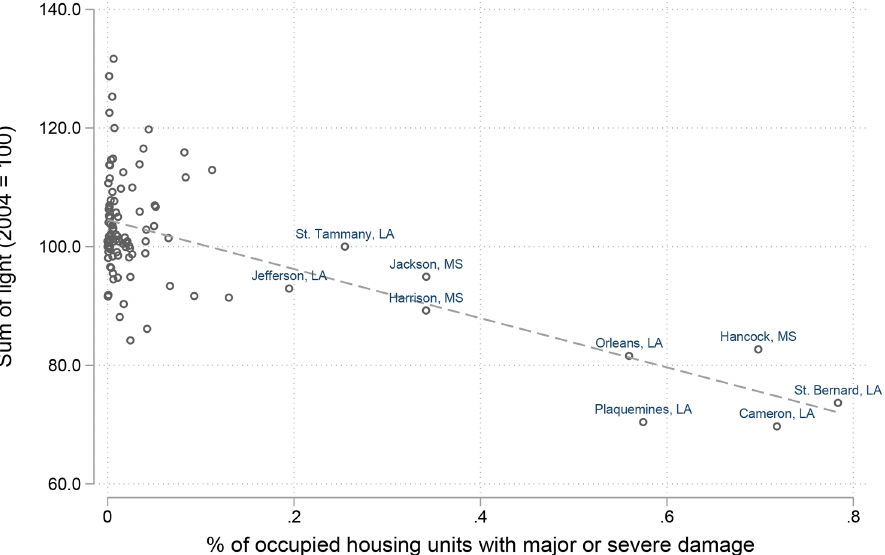
Figure 3. Correlation plot of housing damage and night light reduction in 2005. Data on housing damage in 2005 for Louisiana and Missis- sippi from the U.S. Department of Housing and Urban Development (2006). Nighttime lights are indexed to 2004 = 100 and are calibrated using the Elvidge et al. (2014) method, discussed in detail in Sect. 2.3. Note that the damage and associated night light reduction for Cameron Parish (LA) are linked to Hurricane Rita, which made landfall on the coastline of Texas in 2005. We do not focus on this particular case in the remainder of the paper, as our focus is on Hurricane